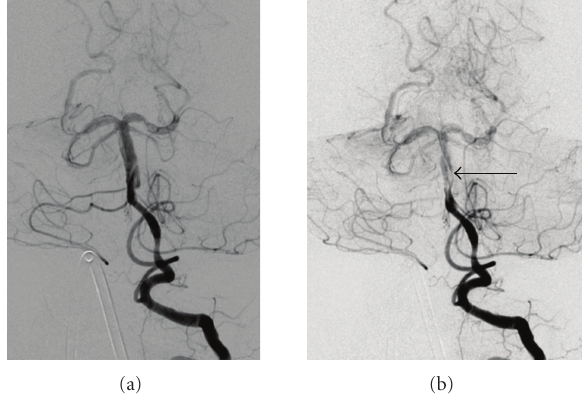
Figure 3: Left vertebral artery injection demonstrates poor opaci- fication of the basilar artery and posterior cerebral arteries (PCAs) despite an adequate contrast bolus. There is marked enlargement of the distal vertebral artery in the vicinity of the vertebrobasilar junction, extending into the basilar artery and the P1 segments of both PCAs. A linear filling defect is noted originating in, and spiraling around the basilar artery and extending into the proximal bilateral PCAs, consistent with a dissection (arrow B). There are also multiple segments of vascular dilatation and narrowing in the bilateral superior cerebellar arteries and distal PCAs consistent with postpartum